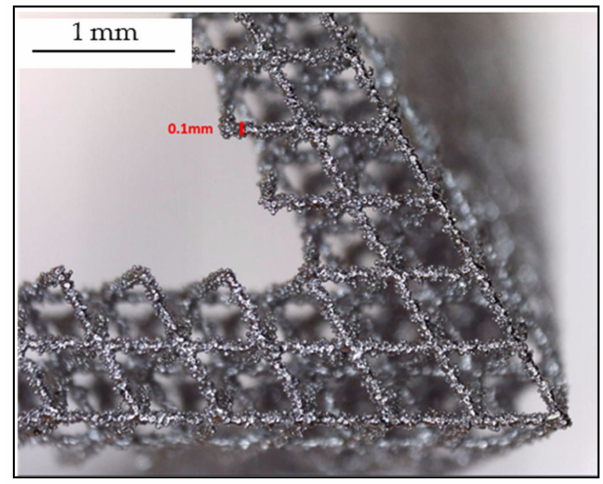
Figure 6. Microscope image of measured bars.